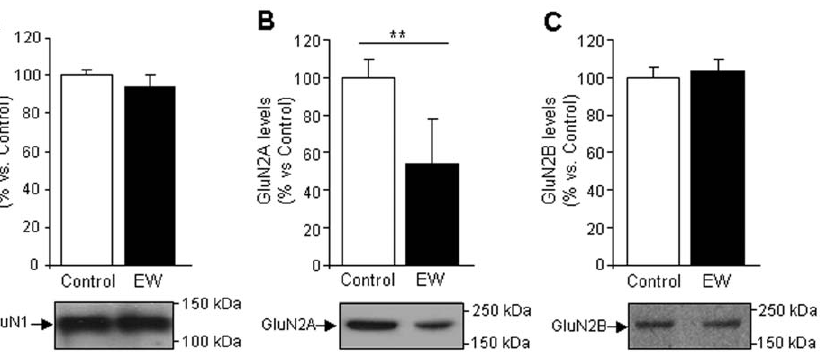
Figure 2. Ethanol withdrawal (EW) decreases GluN2A subunit levels. NMDA subunit protein levels measured by Western blot analysis: GluN2A levels (B) decrease during ethanol withdrawal, whereas the levels of GluN1 (A) and GluN2B (C) remain unaltered. Values are expressed as percentages over control data for each subunit and are means 6 SEM (n=3–5 samples/condition). Data were assessed by the t-Student’s test (** P , 0.01 vs. control).